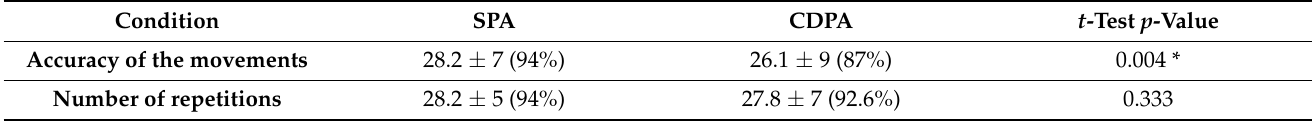
Table A1. Fidelity data for SPA and CDPA, represented for accuracy and number of movements described (range from 0–30) by raw data and percentage (for easier interpretation). Raw data were used for the analyses. * Significant p <